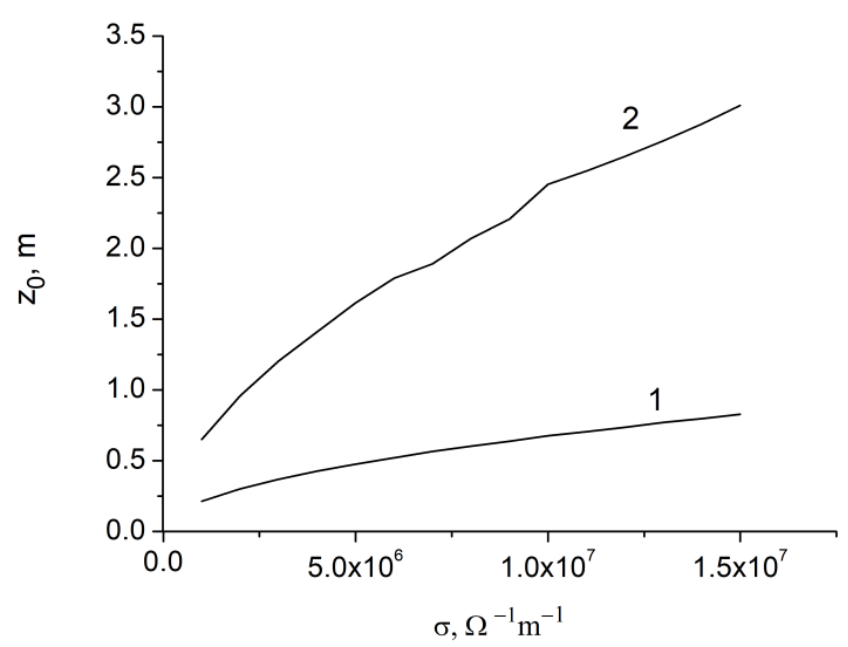
Figure 4. The attenuation length as a function of conductivity. 𝜔 = 0.9 THz; 1 — bare metal wire, 2 — coated metal wire. 𝑟 0 = 100 μm .